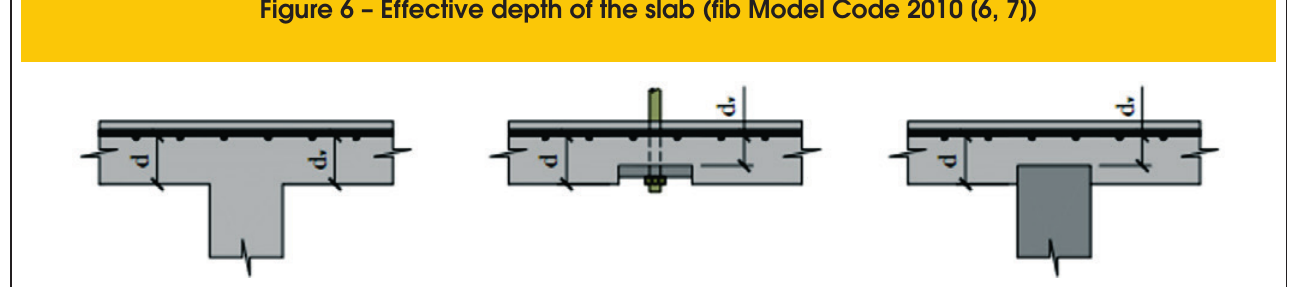
Figure 6 – Effective depth of the slab (fib Model Code 2010 [6,